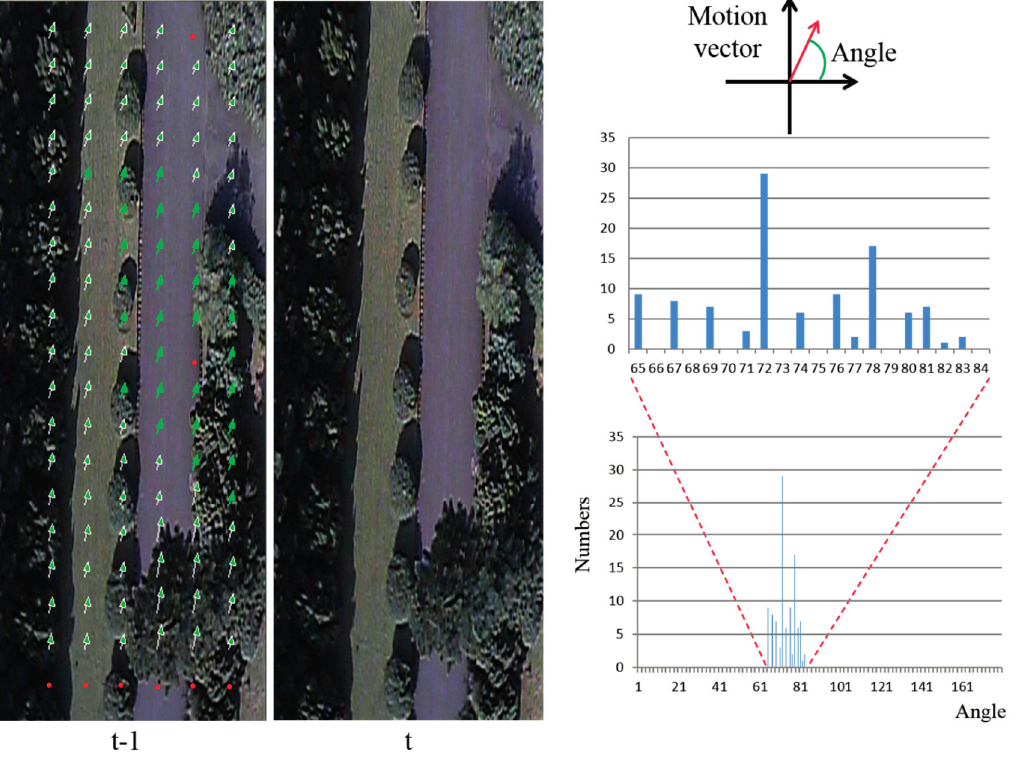
Figure 7. Detected results of the motion vectors.